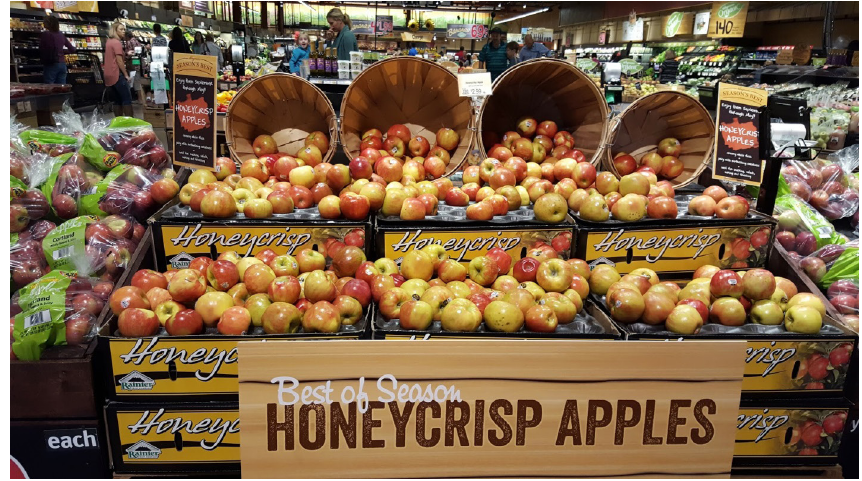
Figure 5 . Seasonal display at the Fredericksburg, Virginia Wegmans, 2016. Photo by